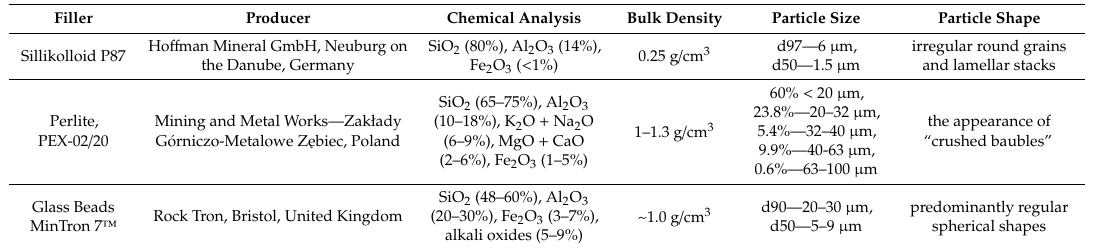
Table 1. Fillers characteristics